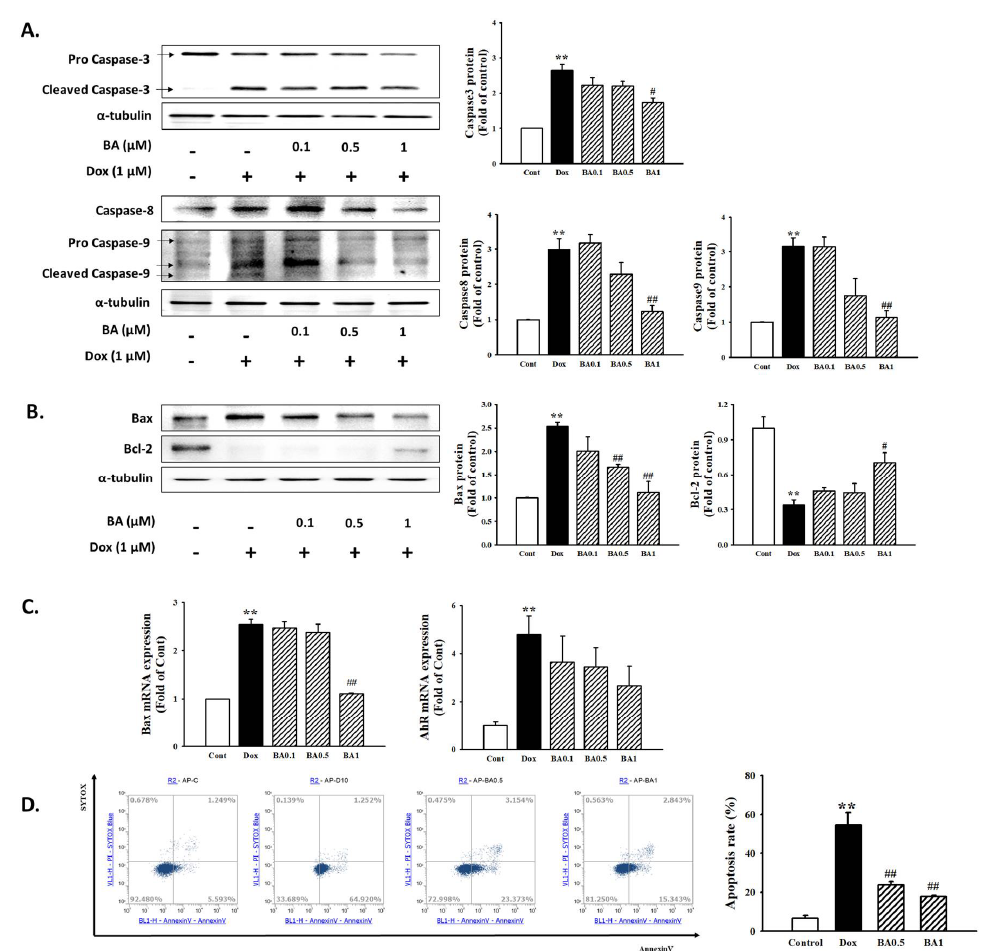
Figure 7. Effect of BA on cell apoptosis in DOX-induced cardiac hypertrophy. ( A ) Western blot analysis results showing the expression levels of apoptosis-related proteins including Caspase-3 and Caspase-9 in DOX-induced H9c2 cells. ( B ) The protein and mRNA expression of Bax and Bcl-2 was examined by Western blot analysis. ( C ) Bax and AhR mRNA expression was examined by real time PCR ( D ) Cell apoptosis was measured using Annexin-V/PI staining and flow cytometry. All experiments were performed at least three times. Data represent mean ± SD. ** p < 0.01, vs. control; # p < 0.05, ## p < 0.01, vs. DOX-treated